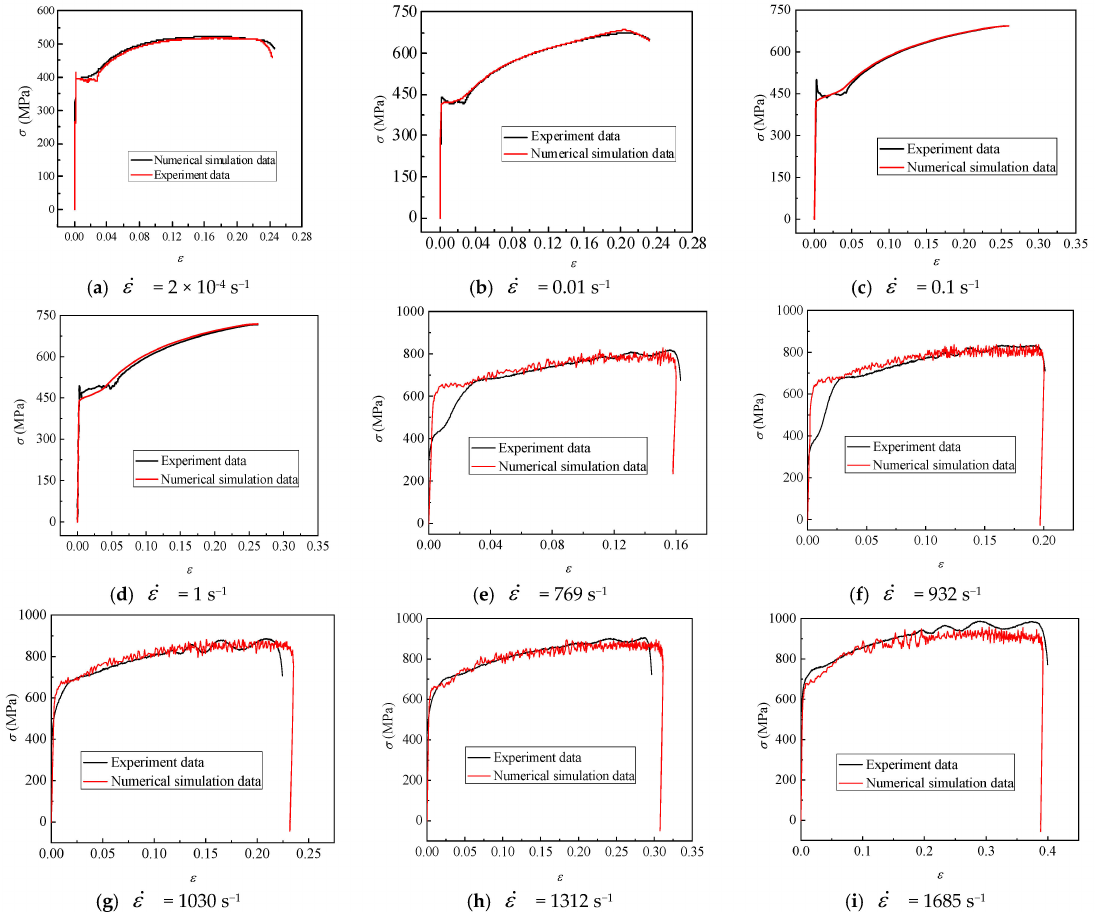
Figure 19. Comparison of numerical and test results at room